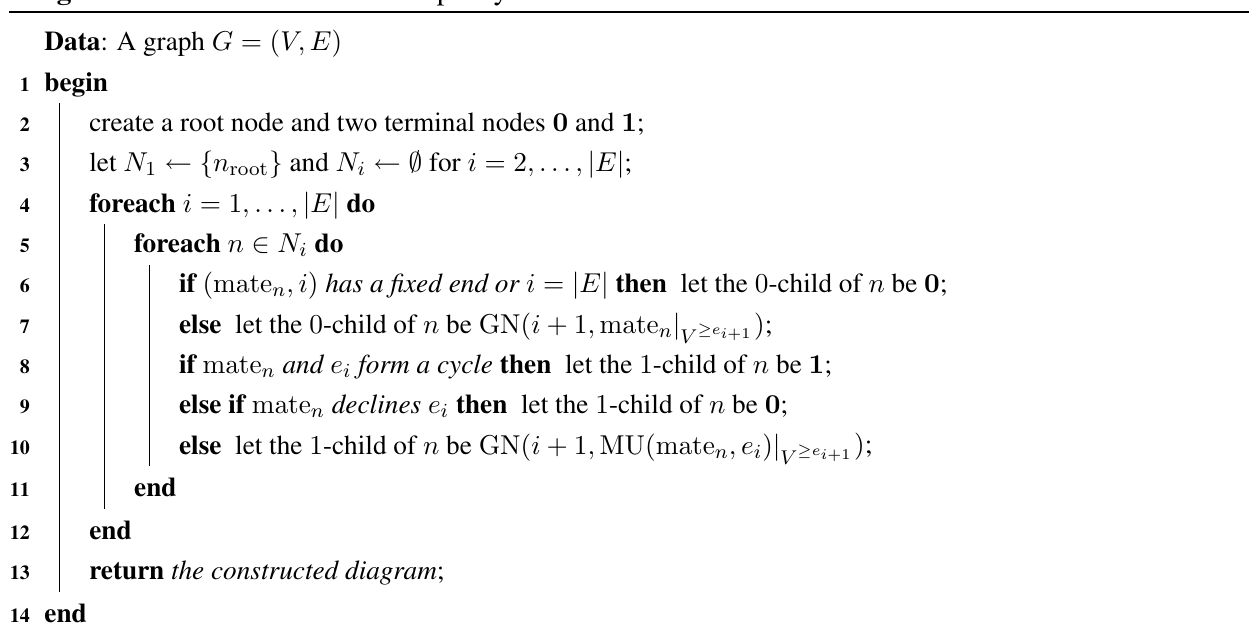
Algorithm 4: Enumeration of simple